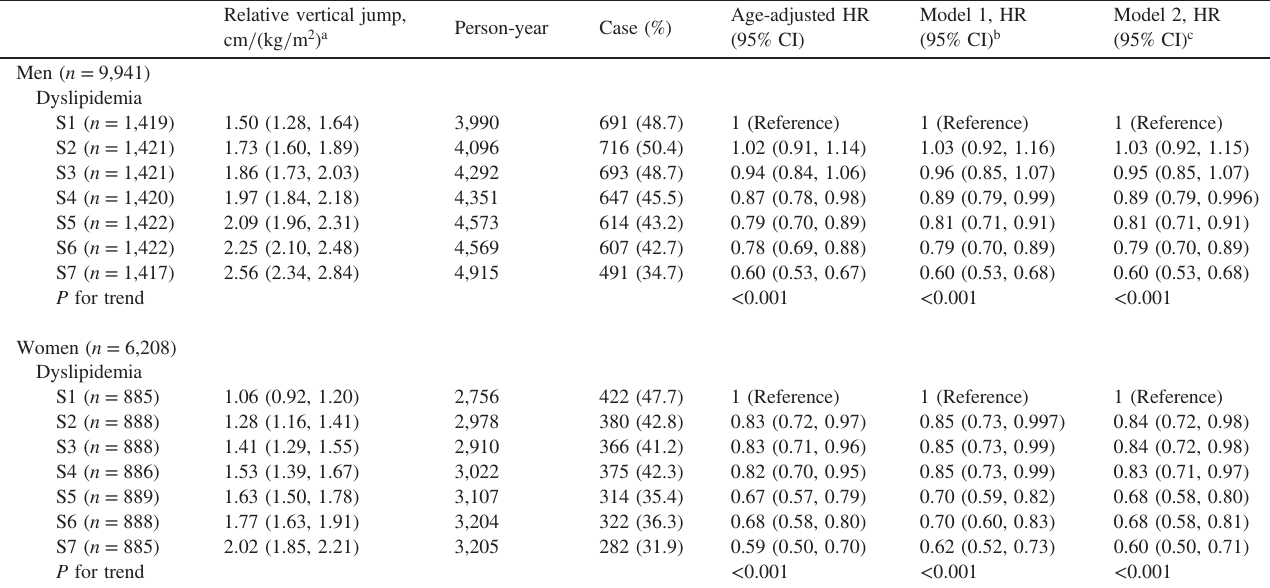
Table 5. Hazard ratios of the incidence of dyslipidemia according to septiles of relative vertical jump among men and women Relative vertical jump, cm = (kg = m 2 )